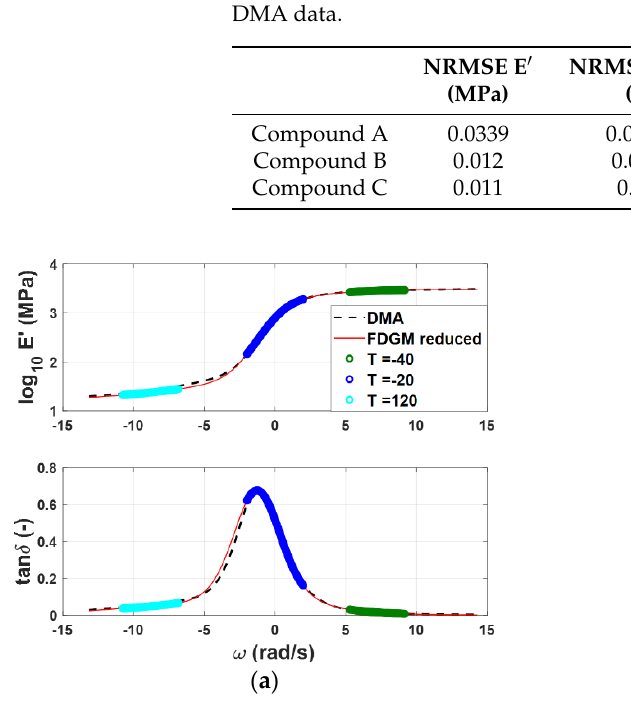
Figure 12. Compound C: Storage modulus and loss tangent ( a ), WLF law ( b ) — experimental data (dashed line) vs. FDGM model complete (light blue) and FDGM obtained with partial staring experimental dataset (red). Table 3. NRMSEs and identified WLF coefficients for compounds A, B, and C in case of partial DMA data.